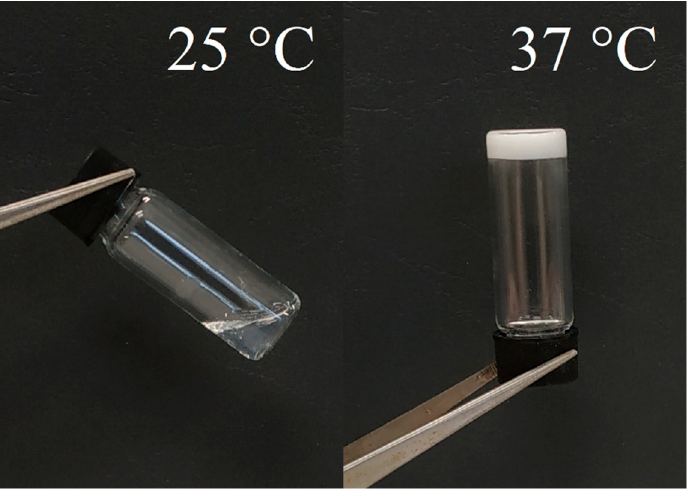
Figure 7. The example of thermosensitive hydrogel phase transition (PCEC-A2.0, concentration 20 wt%).